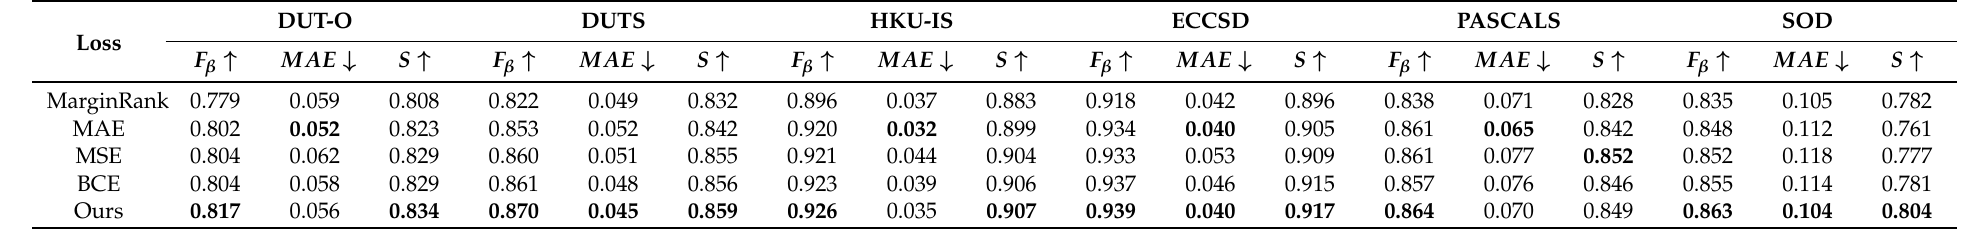
Table 2. Comparison of different loss functions on six datasets. Our loss achieves the best performance under the same setting. The best performance is boldfaced. DUT-O DUTS HKU-IS Loss MarginRank